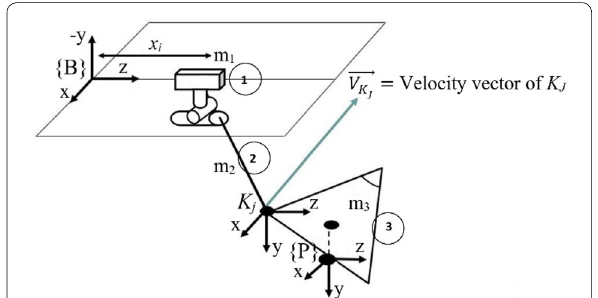
Figure 6 Line diagram representation of a leg in the 3-PRUS